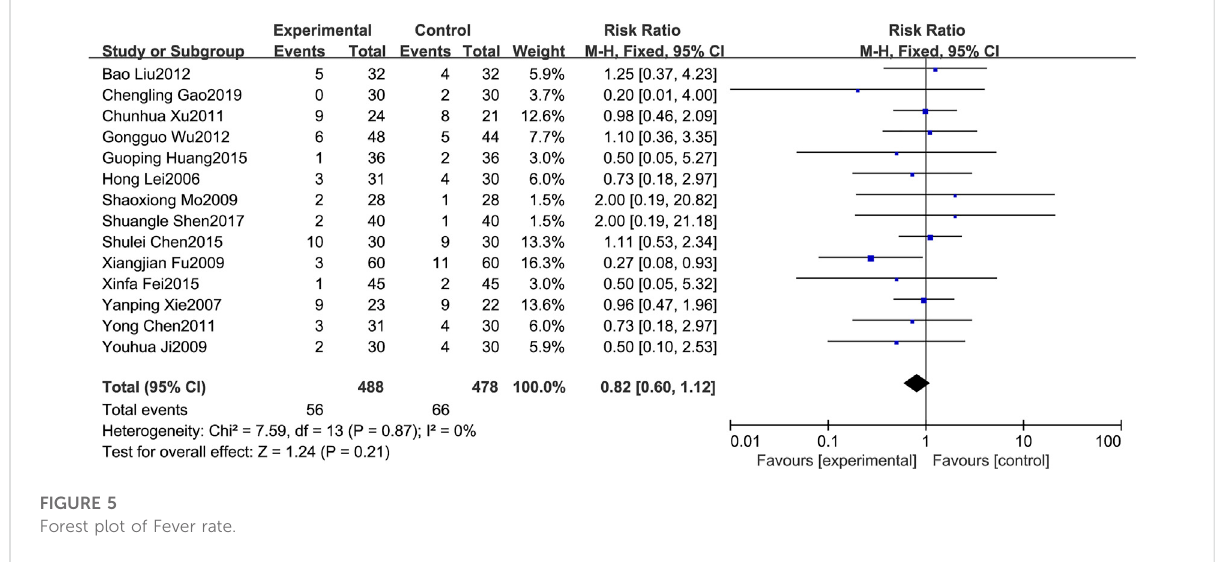
FIGURE 5 Forest plot of Fever rate.